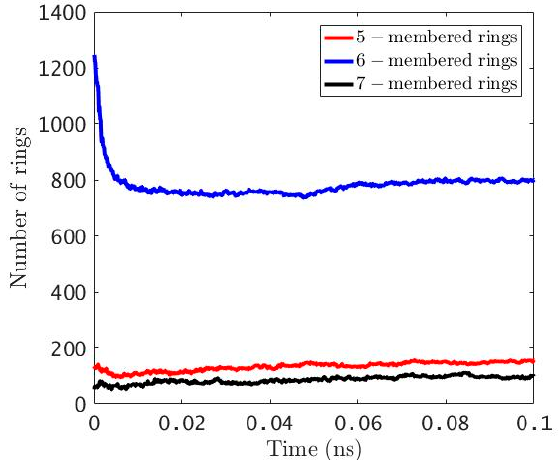
Figure 20. Evolution of carbon rings from atomistic simulation.